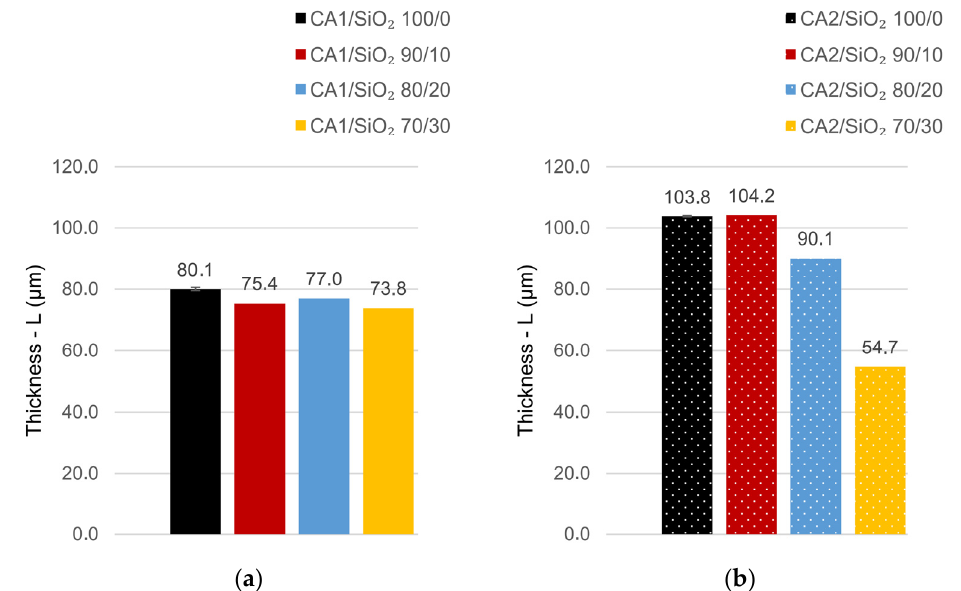
Figure 5. Total membrane thickness in ( a ) series one and ( b ) series two.